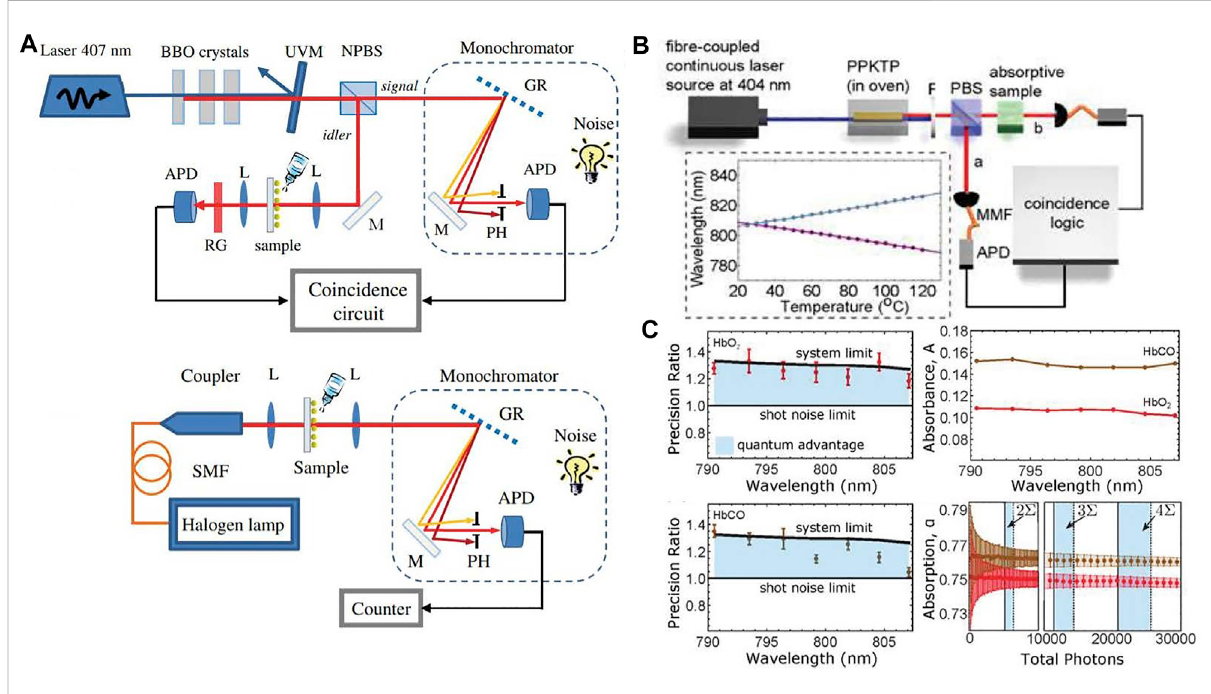
FIGURE 5 (A) Quantumspectroscopysetupbasedoncoincidencedetection ofentangledphotonsandsingle photonmonochromatorfor selectingouta speci fi c frequency, and the conventional transmission spectroscopy by using classical light [27]. (B) Experimental setup for sub-shot-noise spectroscopy by using tunable frequency-entangled photons. (C) Sub-shot-noise absorbance spectra ofHbO2 and HbCO